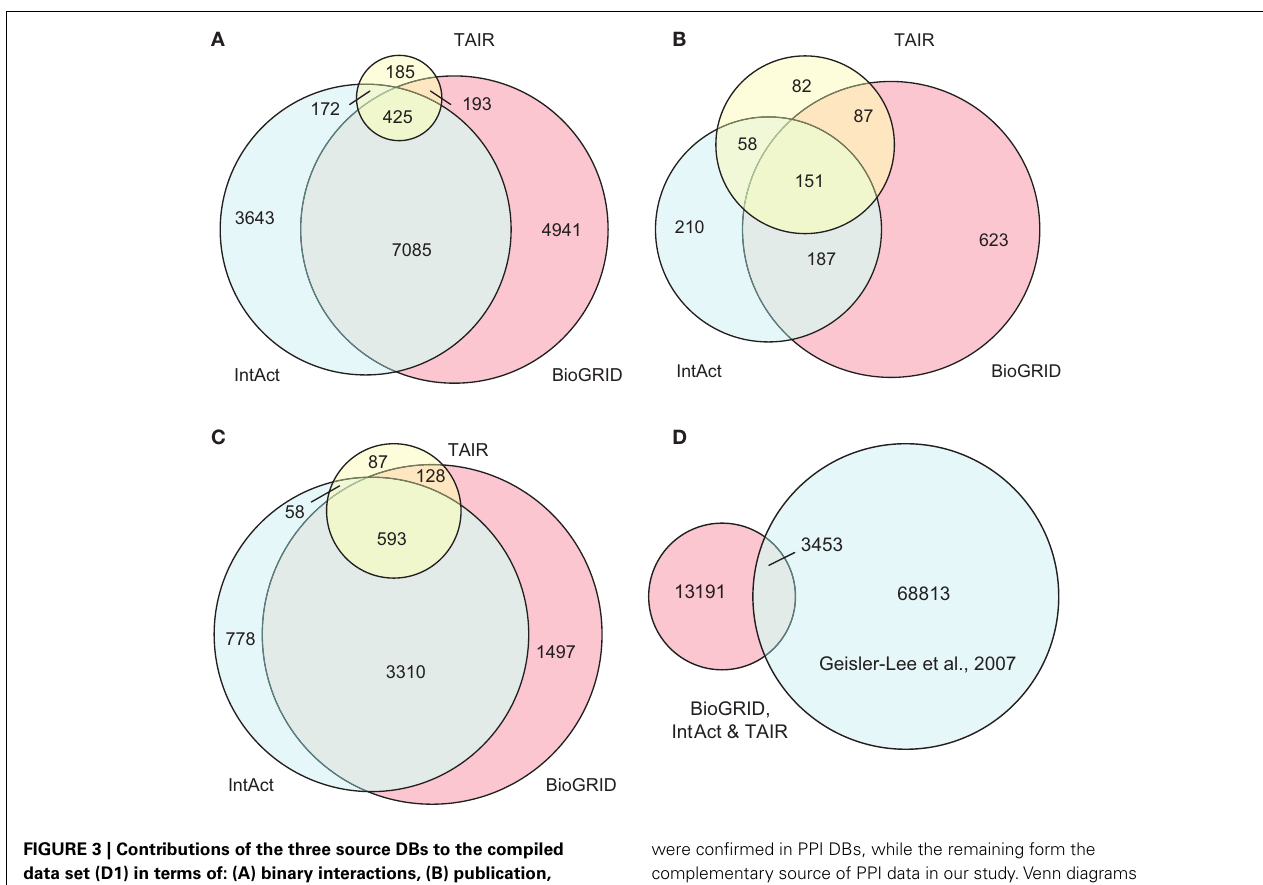
FIGURE 3 | Contributions of the three source DBs to the compiled data set (D1) in terms of: (A) binary interactions, (B) publication, and (C) interacting proteins. The largest contribution comes from BioGrid, although the overlap among the three is significant. (D) A small part of interaction predictions made by Geisler-Lee et al. (2007)